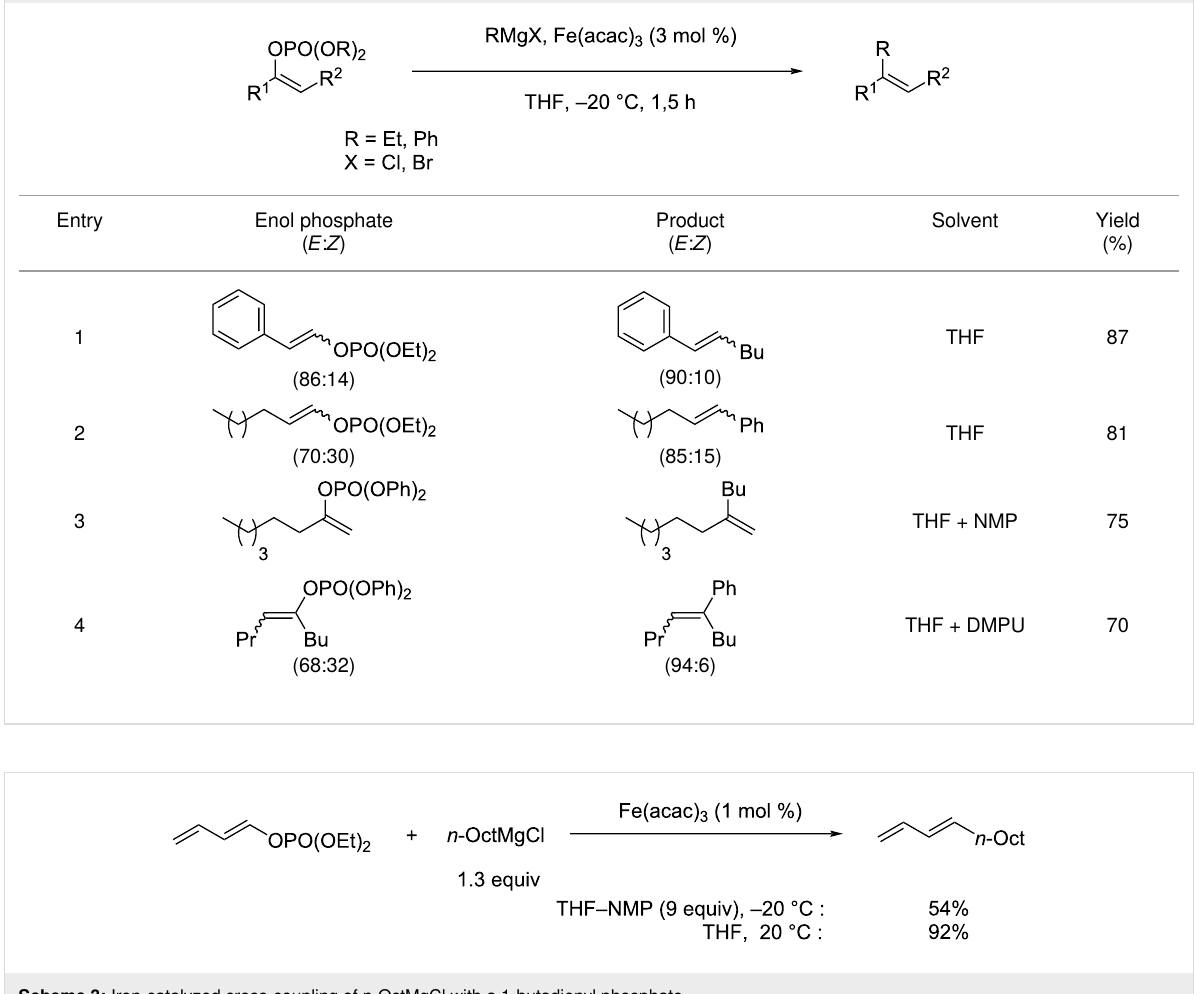
Table 1: Iron-catalyzed alkenylation of enol phosphates by Grignard reagents by